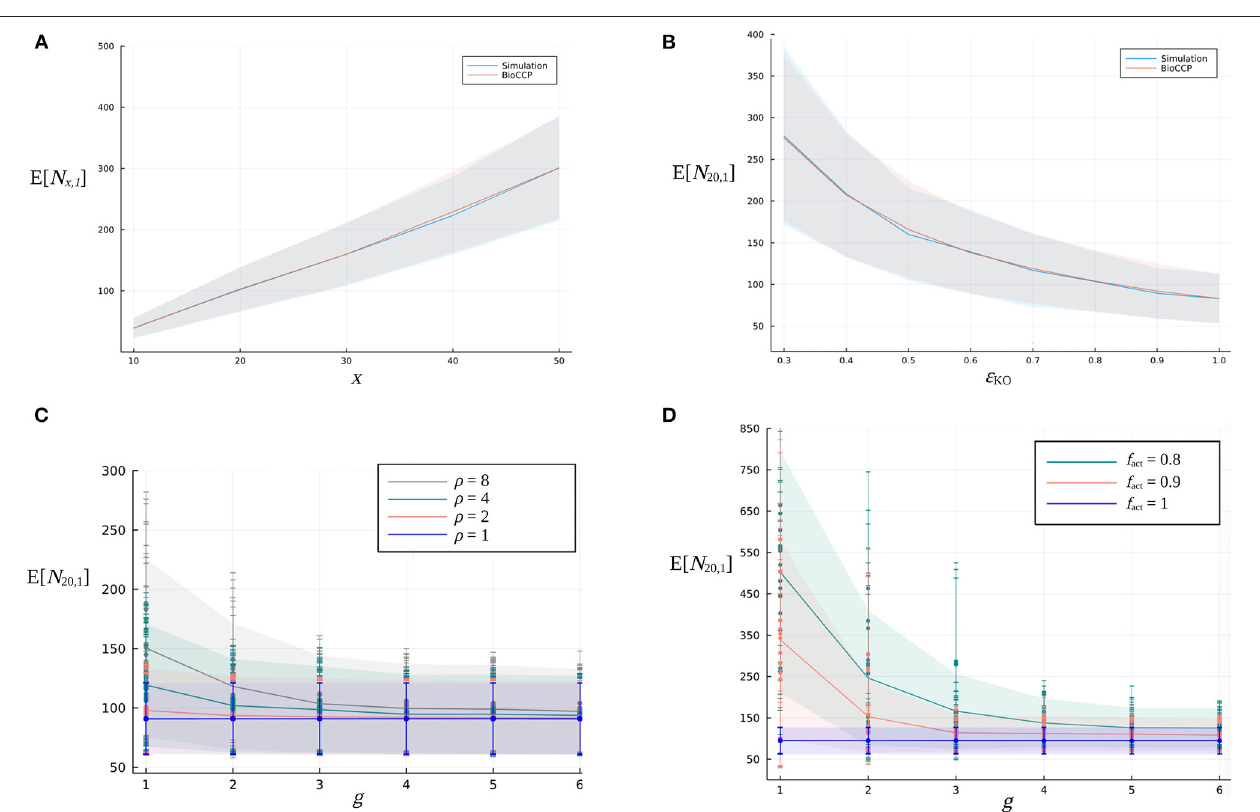
FIGURE 4 | Relation between the expected value of the minimal plant library size for full coverage of all single gene knockouts and design parameters of a multiplex CRISPR/Cas experiment. (A) Effect of an increasing number of x target genes on E[ N x ,1 ]. (B) Effect of the global knockout efficiency ǫ KO on E[ N 20,1 ]. The blue curve indicates the simulation-based results, while the red curve indicates the BioCCP-based results. The width of the shaded area around these curves represents σ [ N 20,1 ]. In each of the graphs, the parameter under investigation is varied while the values of the other parameters are fixed at the default values of the CRISPR/Cas experiment as specified in Table 2 . (C) Effect of parameter ρ , a measure for the width of the gRNA frequency distribution, for an increasing number of g gRNAs per gene on E[ N 20,1 ]. (D) Effect of the fraction f act of active gRNAs for an increasing number of g gRNAs per gene on E[ N 20,1